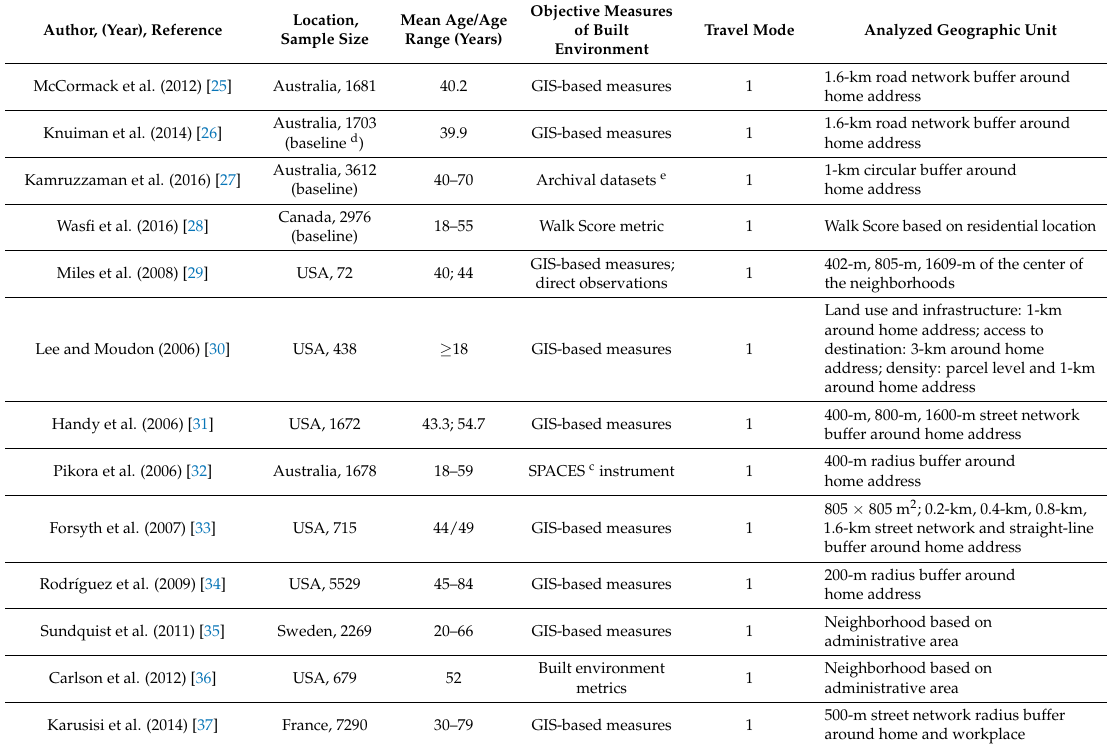
Table 4. Summary of study